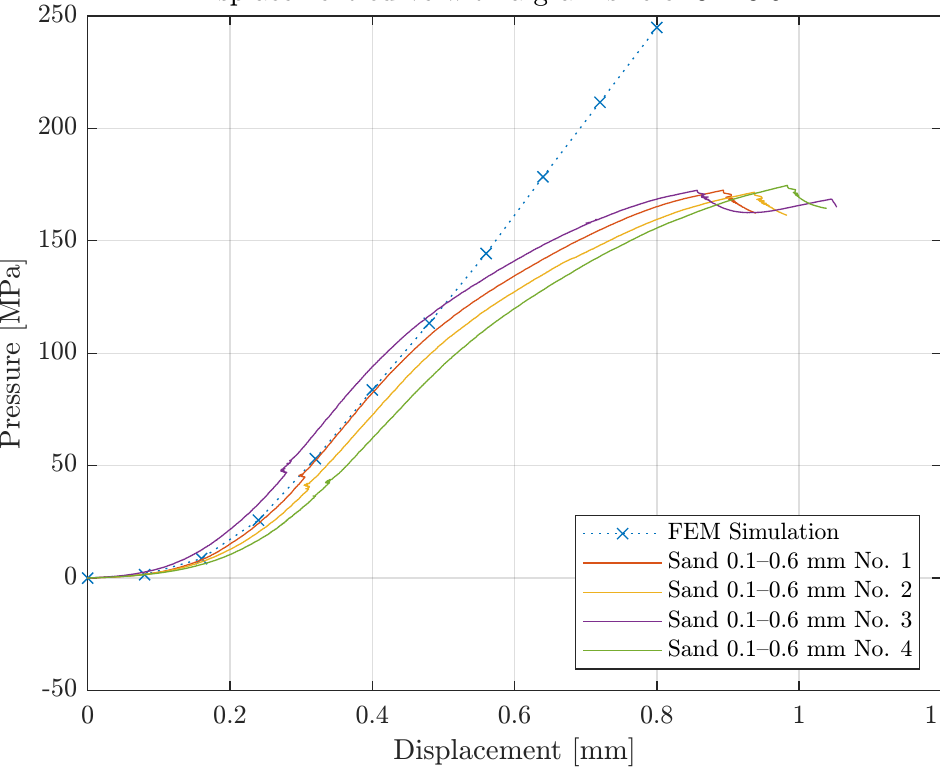
Figure 9. Comparison of modeled and measured pressure overclosure between CFRP lamella with sand at 0.1–0.6 mm and